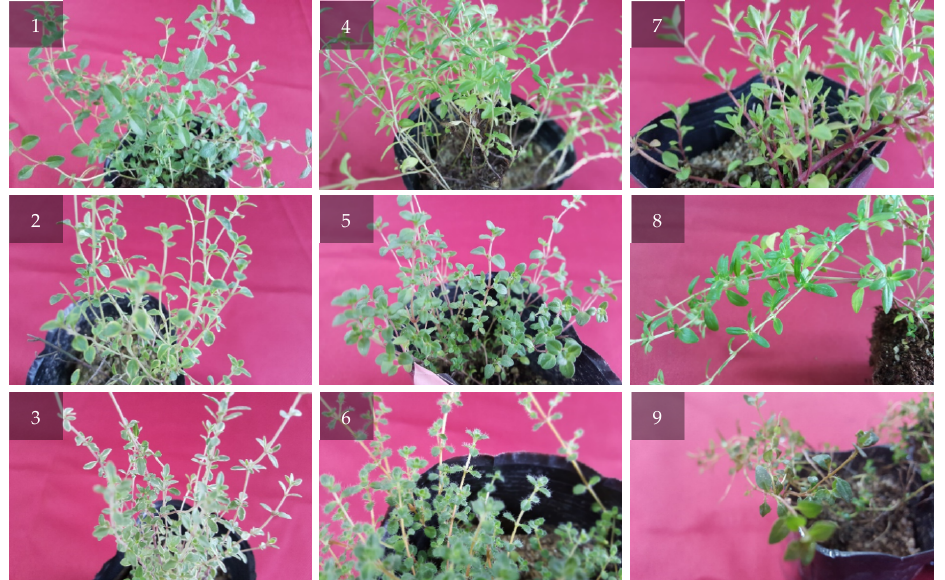
Figure 2. The morphology of six commercial Thymus vulgaris cultivars and three Korean native Table